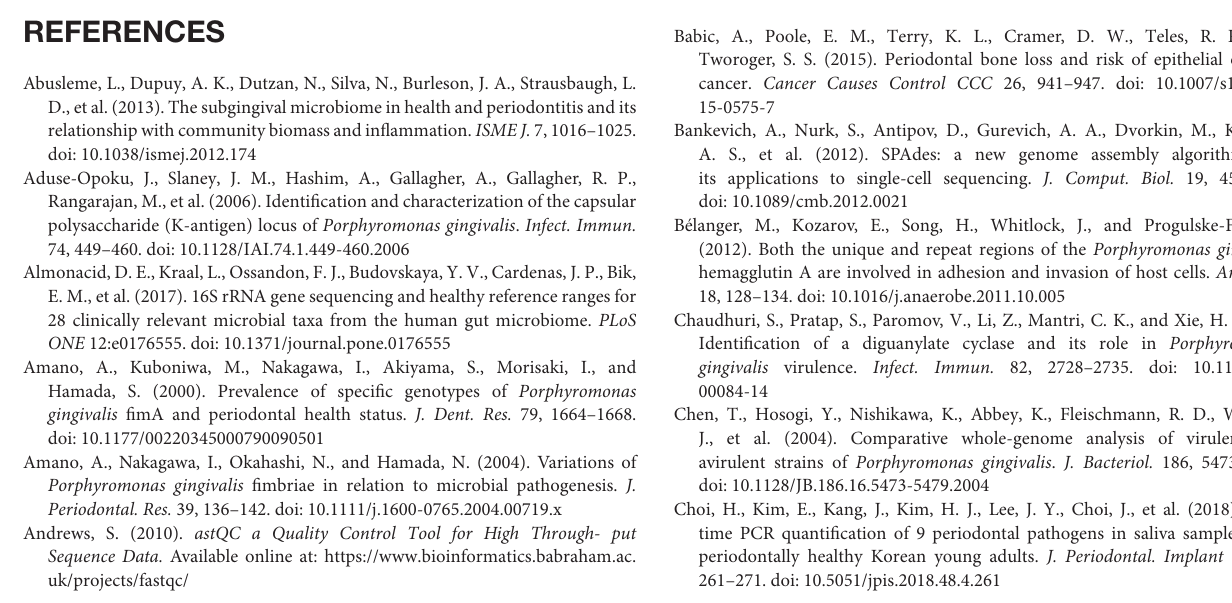
Table S1 | Periodontal parameters of the subjects from whom Porphyromonas gingivalis strains CP3 and H3 were obtained. PD, pocket depth; CAL, clinical attachment level. Table S2 | Sequencing, quality control (QC) of reads, and assembly of the Porphyromonas gingivalis strains CP3 and H3 genomes. The first panel “Sequencing and quality control (QC)” shows the number of sequenced reads and the number of reads after QC. The quality-controlled reads were used for de novo assembly of CP3 and H3 genomes. Statistical features of both assembled genomes are shown in the second panel “Genome assembly,” including the number of predicted proteins and the presence of bacterial orthologs (“Proteome completeness”). C, complete orthologs; S, complete and single-copy orthologs; D, complete and duplicated orthologs; F, fragmented orthologs; M, missing orthologs. Table S3 | Publicly available Porphyromonas gingivalis genomes used in this study. Sixty-two P. gingivalis genomes were downloaded from NCBI’s RefSeq database in February 2018. Table S4 | Average nucleotide identity and coverage values for the 64-genome Porphyromonas gingivalis dataset. Sheets 1, 2 show the average nucleotide identity and coverage values, respectively. Sheets 3, 4 detail the identity and coverage values, respectively, of all P. gingivalis strain genomes against CP3 and H3